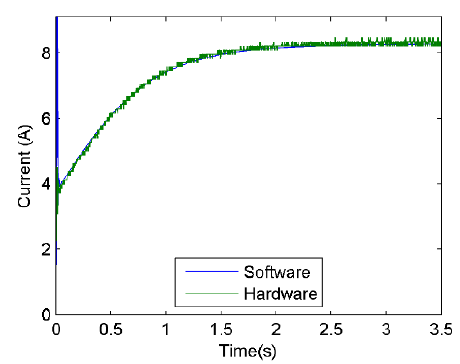
Figure 31. PVPE current response with PI CSE.